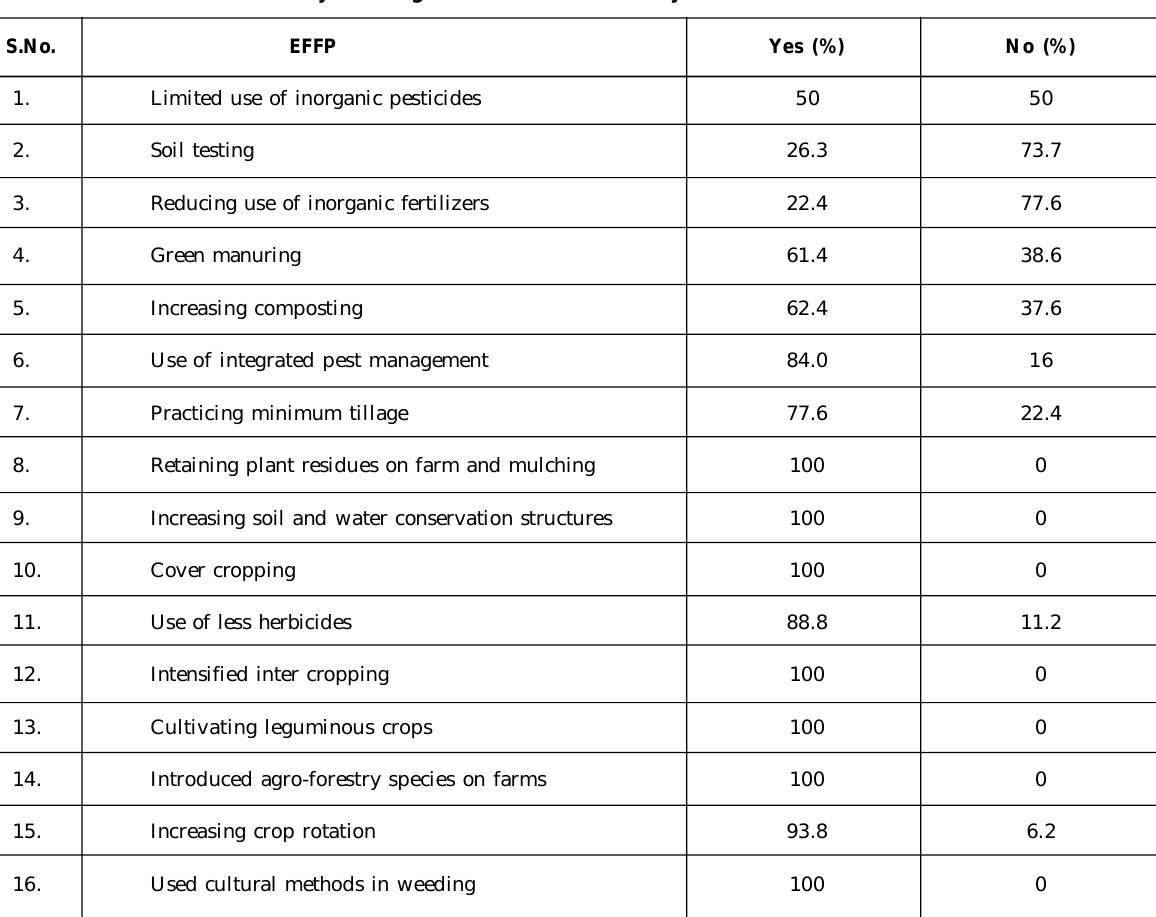
Table 3: Common Eco-Friendly Farming Practices as observed by extension officers